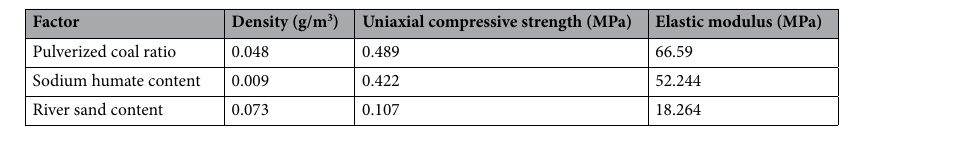
Table 7. The range of each level of each